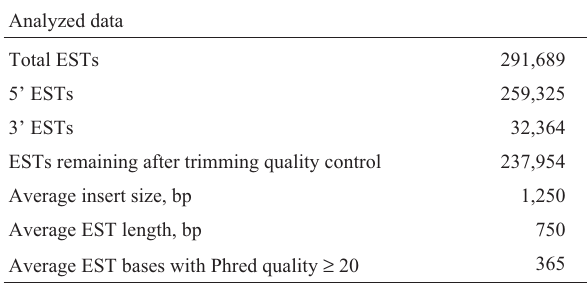
Table III - Summary of SUCEST data. Table IV - Characteristics of the SUCEST